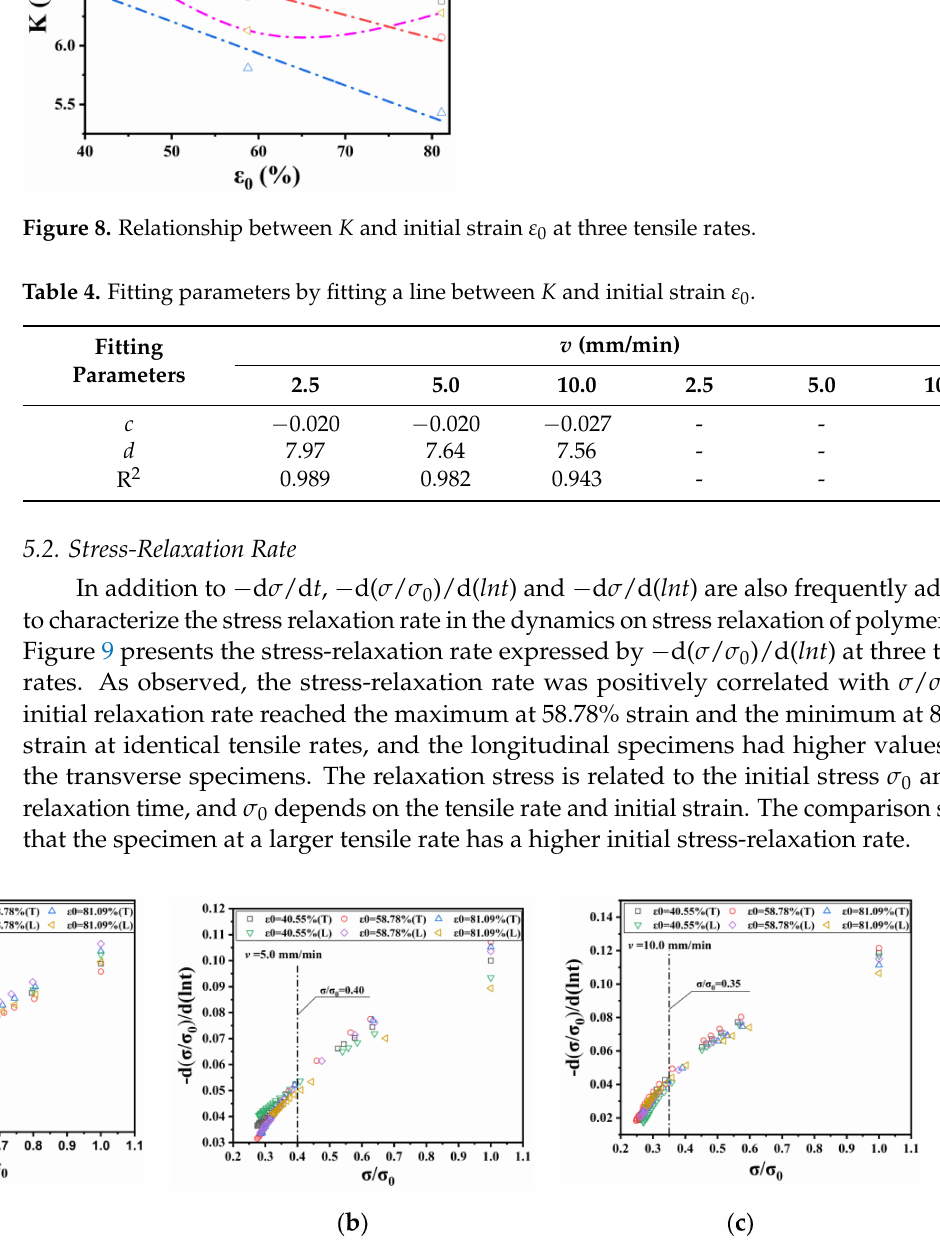
Figure 9. Stress-relaxation rate at different tensile rates: ( a ) v = 2.5 mm/min; ( b ) v = 5.0 mm/min; ( c ) v = 10.0